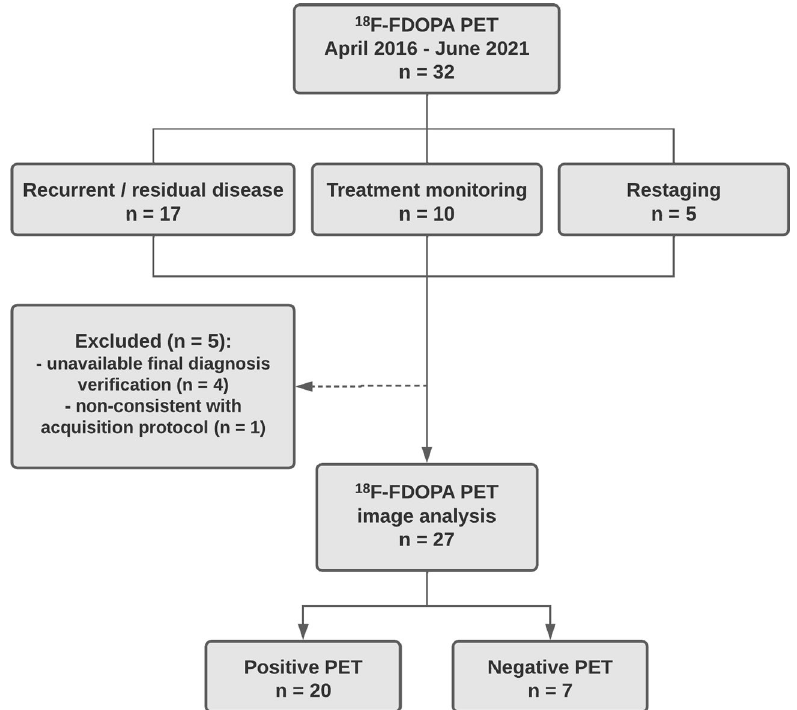
Fig. 1 Flowchart showing the study population and [ 18 F]FDOPA PET/CT results of included scans